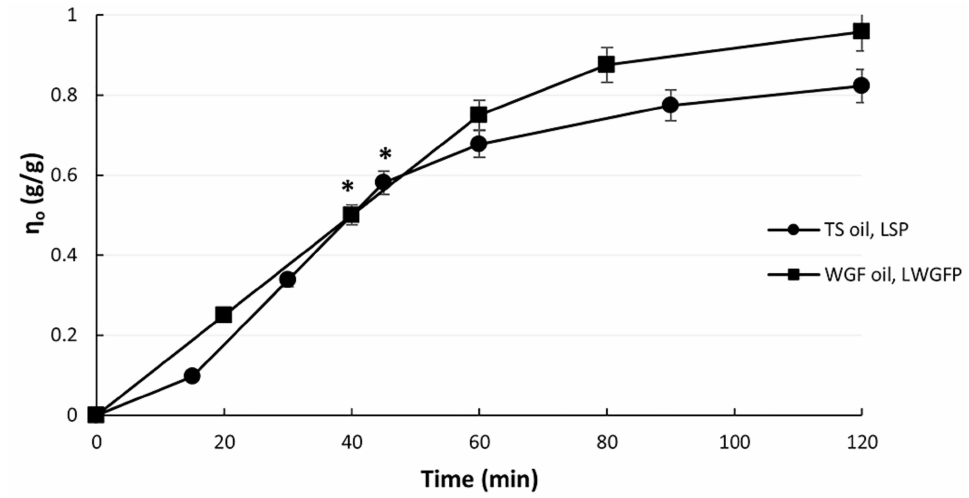
Figure 2. Tomato seed and wheat germ flour oil extraction yields ( η o ) vs. extraction time, evaluated during trials #6 and #7 performed with layered configurations (LSP and LWGFP, respectively). p > 0.05 for all the points marked with asterisks, *.